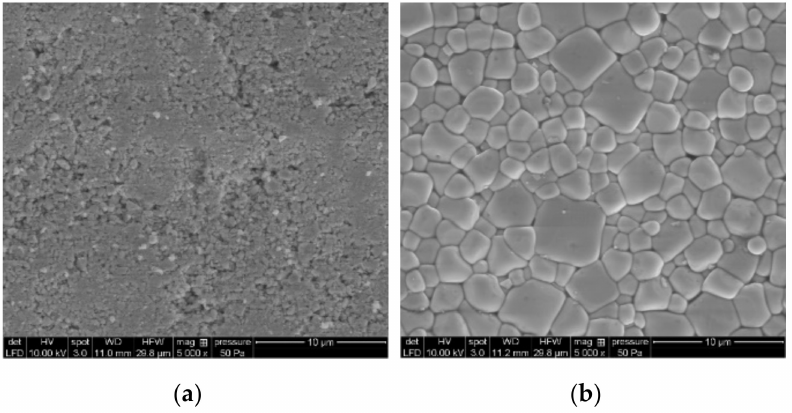
Figure 2. SEM image of the sample ( a ) before and ( b ) after sintering.